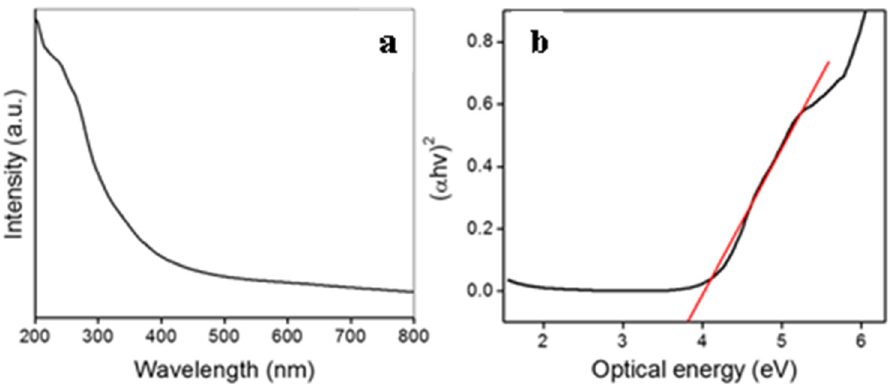
Figure 2. ( a ) UV/Visible absorption spectrum and ( b ) Tauc plot of neodymium selenide nanoparti-